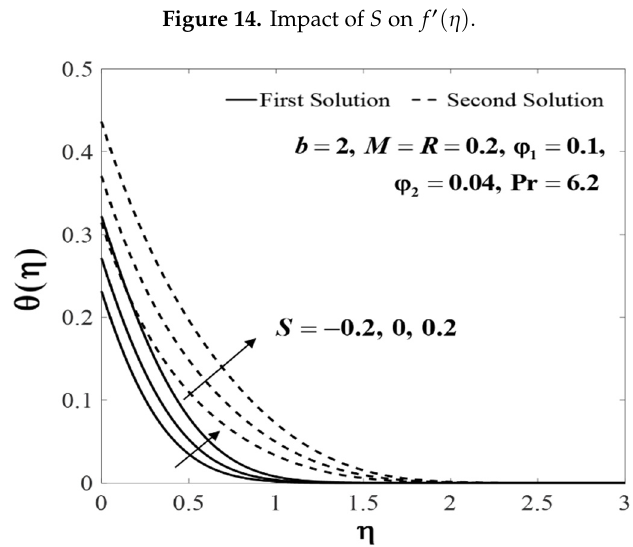
Figure 15. Impact of S on θ ( η ) .